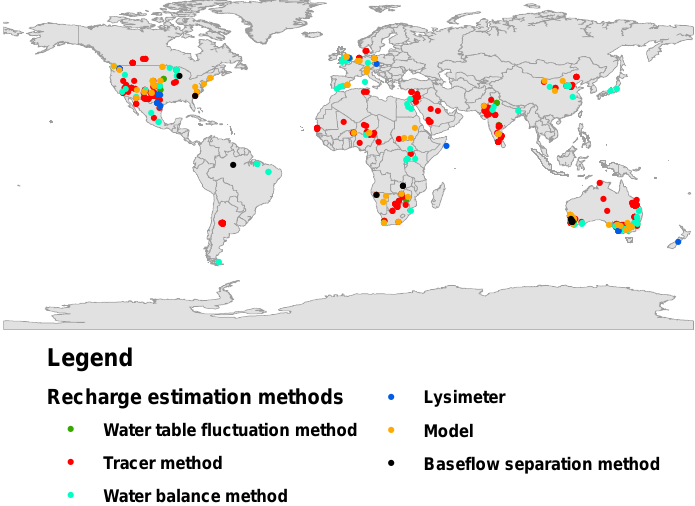
Figure 1. Locations of the 715 selected recharge estimation sites and the corresponding recharge estimation method, used for model building.